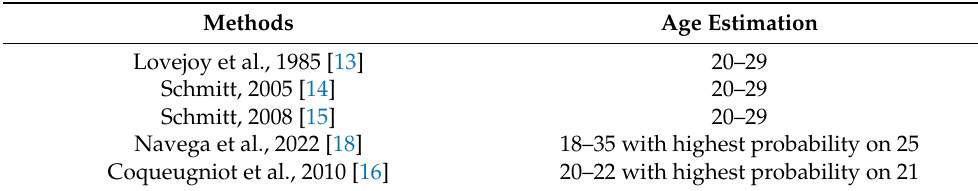
Table 3. Example of methods used on an age-known French soldier who died in 1915 at 20 years old and had been discovered in